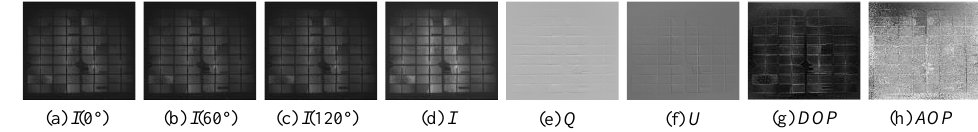
Figure 7. SWIR polarization image of monocrystalline silicon solar panel.